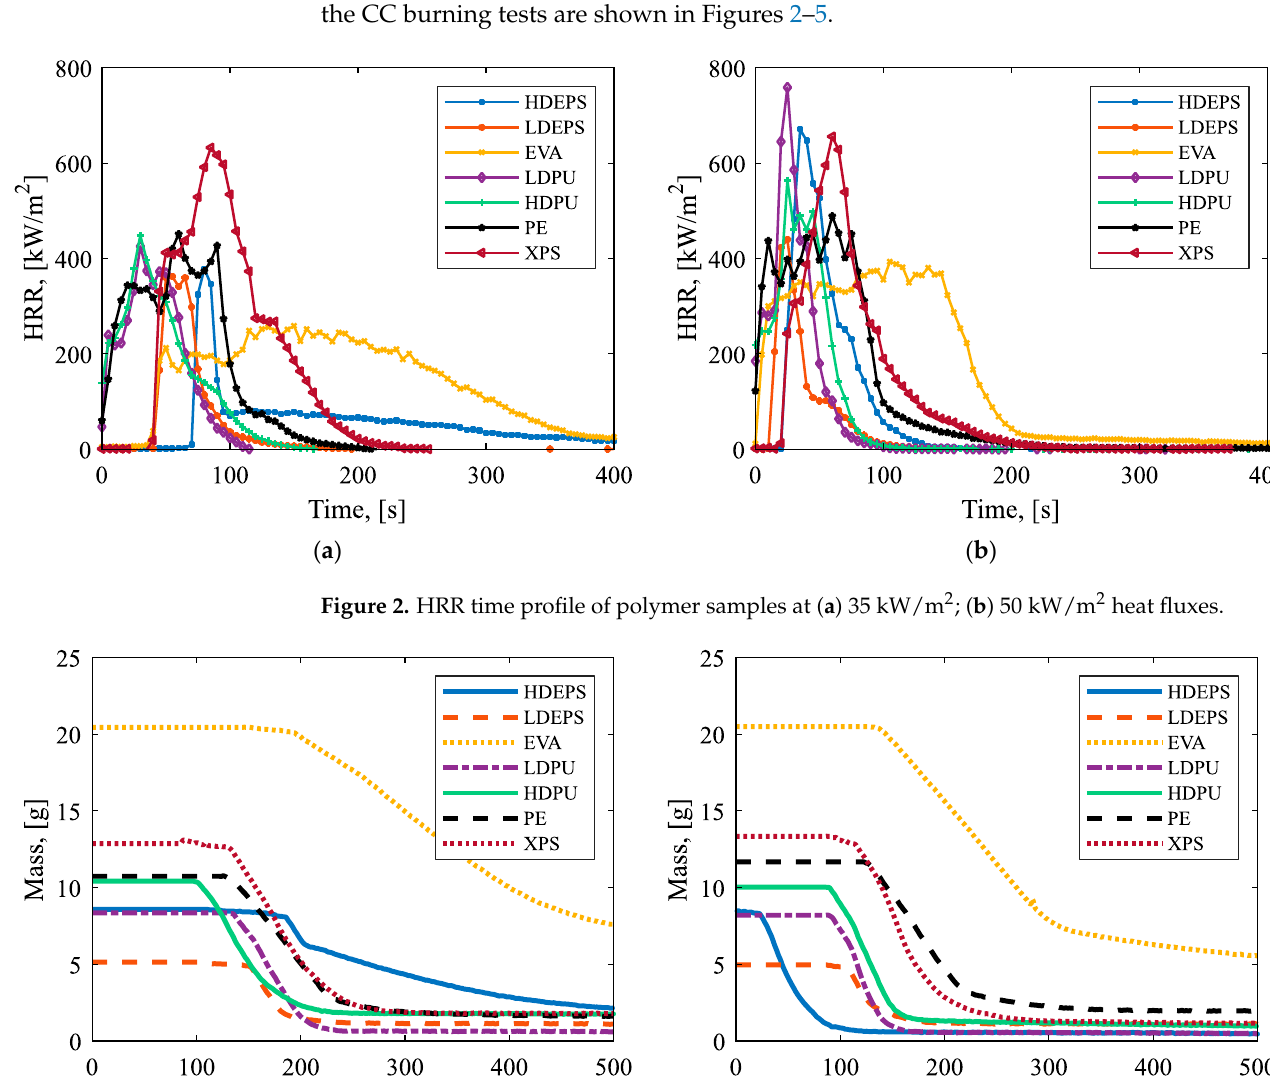
( b ) Figure 4. TSR time profile of polymer samples at ( a ) 35 kW/m 2 ; ( b ) 50 kW/m 2 heat fluxes. ( a ) ( b ) Figure 5. SPR time profile of polymer samples at ( a ) 35 kW/m 2 ; ( b ) 50 kW/m 2 heat fluxes.